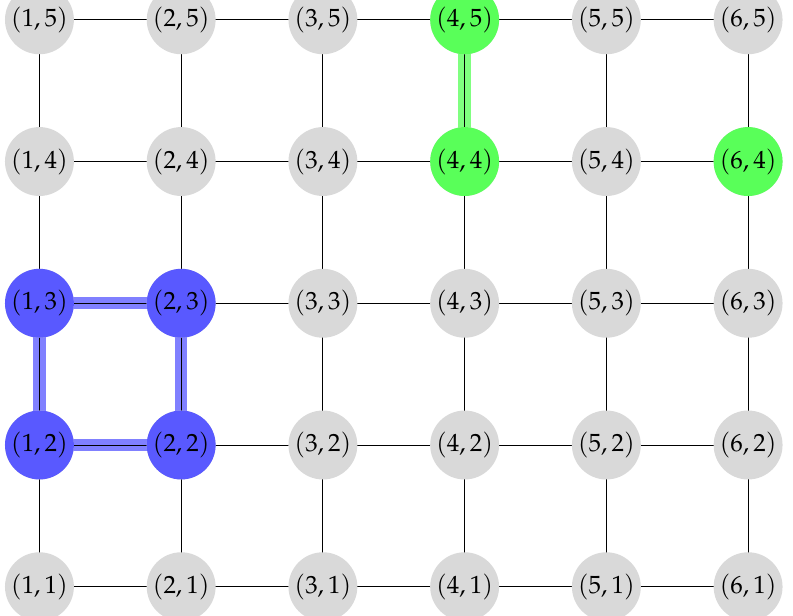
Figure 2. The blue subgraph is connected, while the green one is